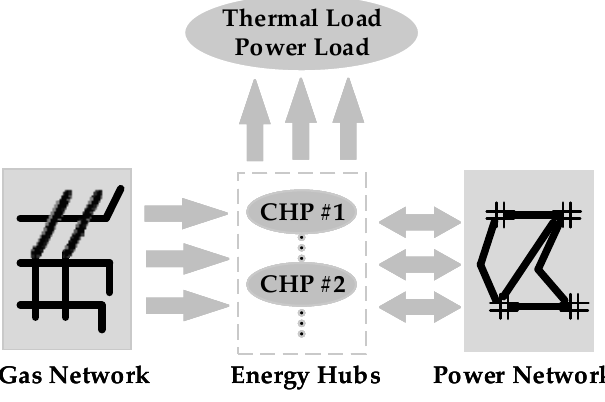
Figure 1. Framework of CHP based hybrid energy networks.